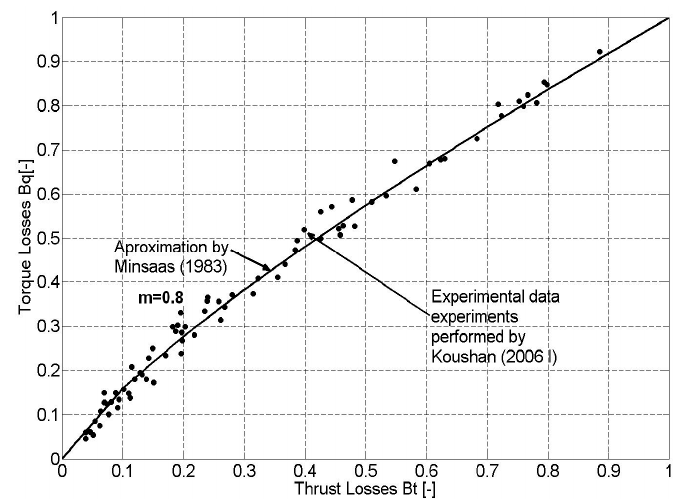
Figure 1. Relation between thrust and torque loss factors, based on experiments Kou2006_I.